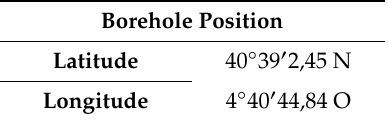
Table 1. Location of the borehole where this research is